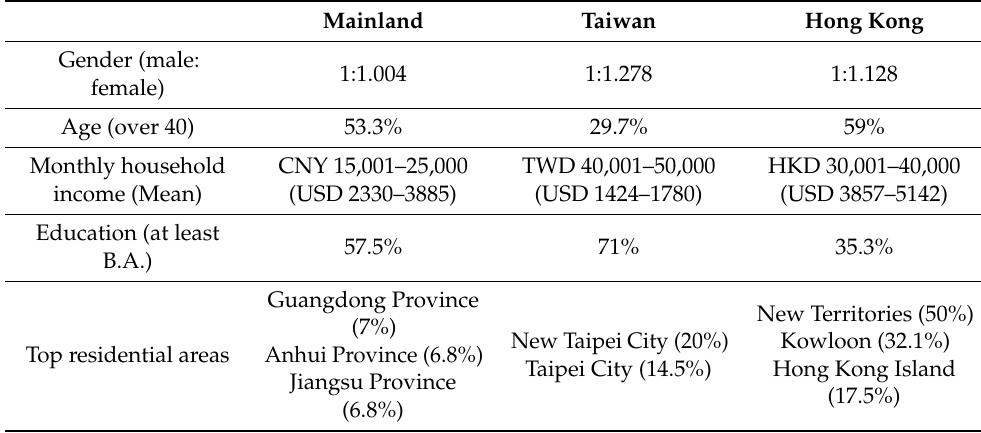
Table 1. Descriptive results in three Chinese